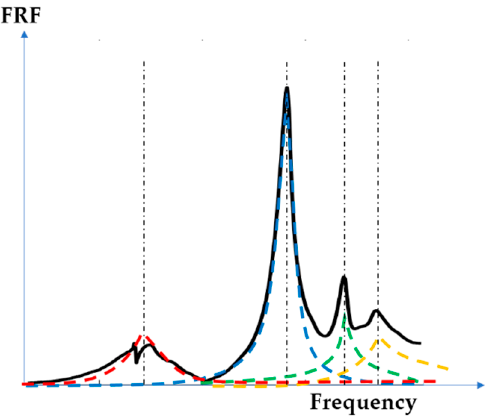
Figure 4. Modal model as the superposition of different single-degree-of-freedom (SDOF) contributions. FRF—frequency response function.